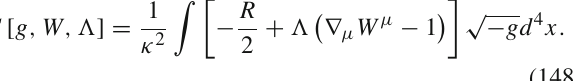
Fig. 3 ThedimensionlessHubblefunction(leftpanel)andthedeceler- ation parameter (right panel) as a function of the redshift z for the addi- tive case of the f ( R , L m , T ) gravity theory, with L m = − ρ , for four differentvaluesoftheconstants ¯ β and ¯ γ : ¯ β = 0 . 12and ¯ γ = 0 . 0(dashed curve), ¯ β = 0 . 0 and ¯ γ = − 0 . 14 (long-dashed curve), ¯ β = − 0 . 12 and